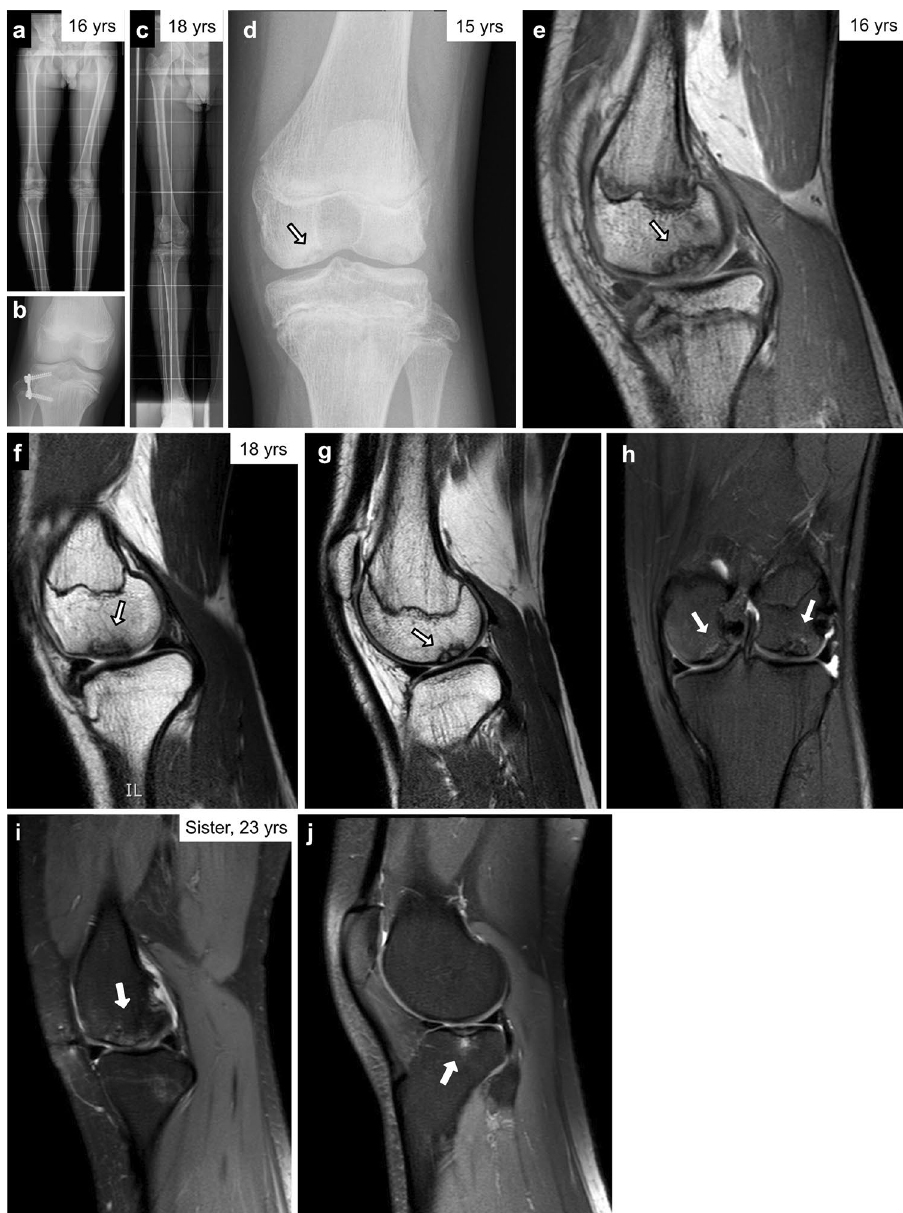
Figure 1. Clinical observations in Family 2. The proband is an 18 years old man with short stature (height 127.5 cm at 13 years old, − 3.5 SDS), normal birth history and development, and a family history of short stature. The proband was treated with GH from the age of 14. At 16 years of age, the proband was still on GH treatment and presented with bilateral knee pain and right-sided genu varum ( a ) that was corrected surgically ( b , c ). His knees at 15 ( d ), 16 ( e ) and 18 years of age ( f – h ) showed OCD. Both his 23-year-old sister ( i , j ) and his 46-year-old mother (143 cm, not shown) have short stature and OCD. Arrows indicate osteochondral